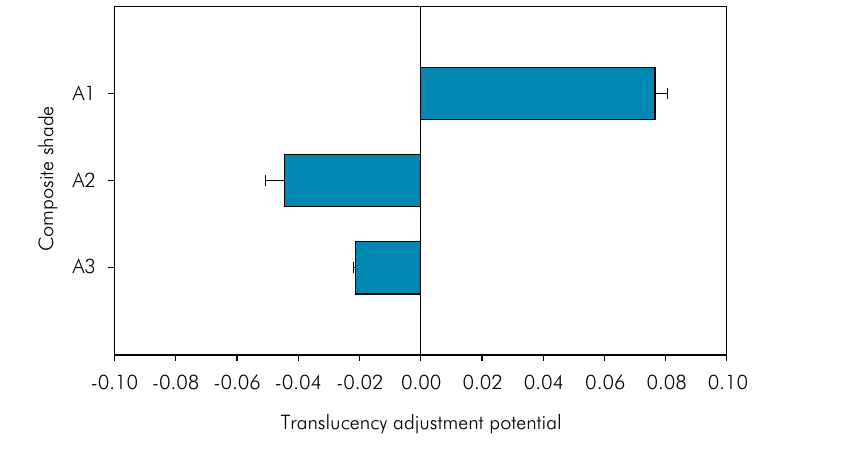
Figure 2. Means and standard deviations of the translucency adjustment potential (TAP) according to the composite shade. Distinct letters indicate significant differences according to Tukey`s test (p < 0.05).